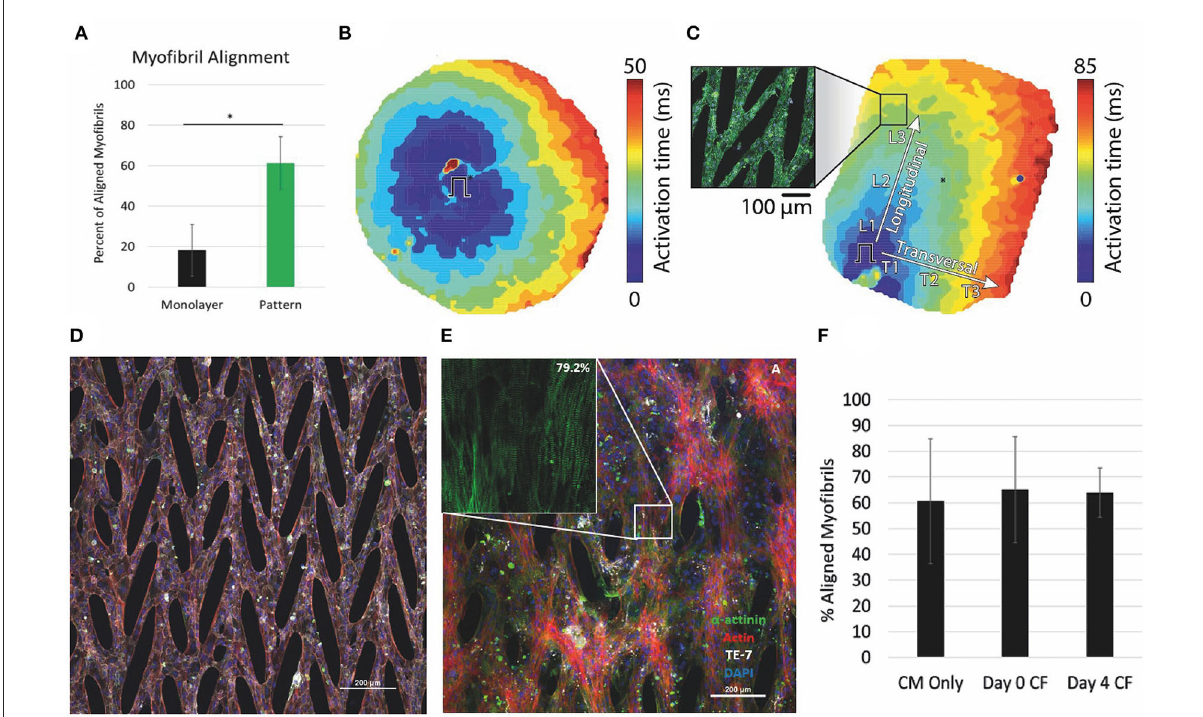
FIGURE2 Micropattern culture of iPS-CMs results in anisotropic conduction and improved myofibril alignment, which is maintained in coculture with CFs. (A) Percent of myofibrils aligned within 10 degrees of the primary axis significantly different in monolayers vs micropatterned. (B,C) Optical mapping of (B) monolayer and (C) micropatterned iPS-CMs. Ansiotropic conduction in patterned determined by comparison of the longitudinal (CVL) and transverse (CVT) conduction velocities. (D) iPS-CMs cultured on micropattern alone. Scale bar 200 µ M. (E) Aligned myofibrils of iPS-CMs seeded on micropatterned substrate maintained in co-culture with CFs at 18 days. Inset shows myofibrils with 79% of sarcomeres within 10 degrees of the superior angle. Scale bar 200 µ M. (F) Quantification of the percent of myofibrils aligned within 10 degrees of the superior angle at 18 days for the three conditions: iPS-CMs cultured alone, iPS-CMs co-cultured with CFs from Day 0 seeding, iPS-CMs co-cultured with CFs from Day 4 of seeding. (A–C) modified from (97), (D,E) unpublished data, and (F) modified from